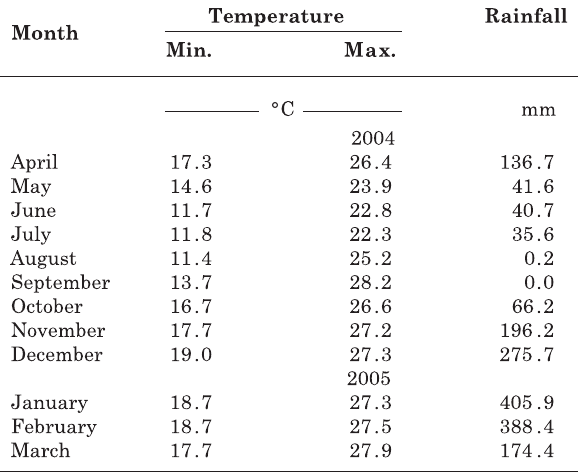
Source: Matos (2005). Table 2. Chemical and biochemical composition of plant material used for simulation (Matos, 2005)